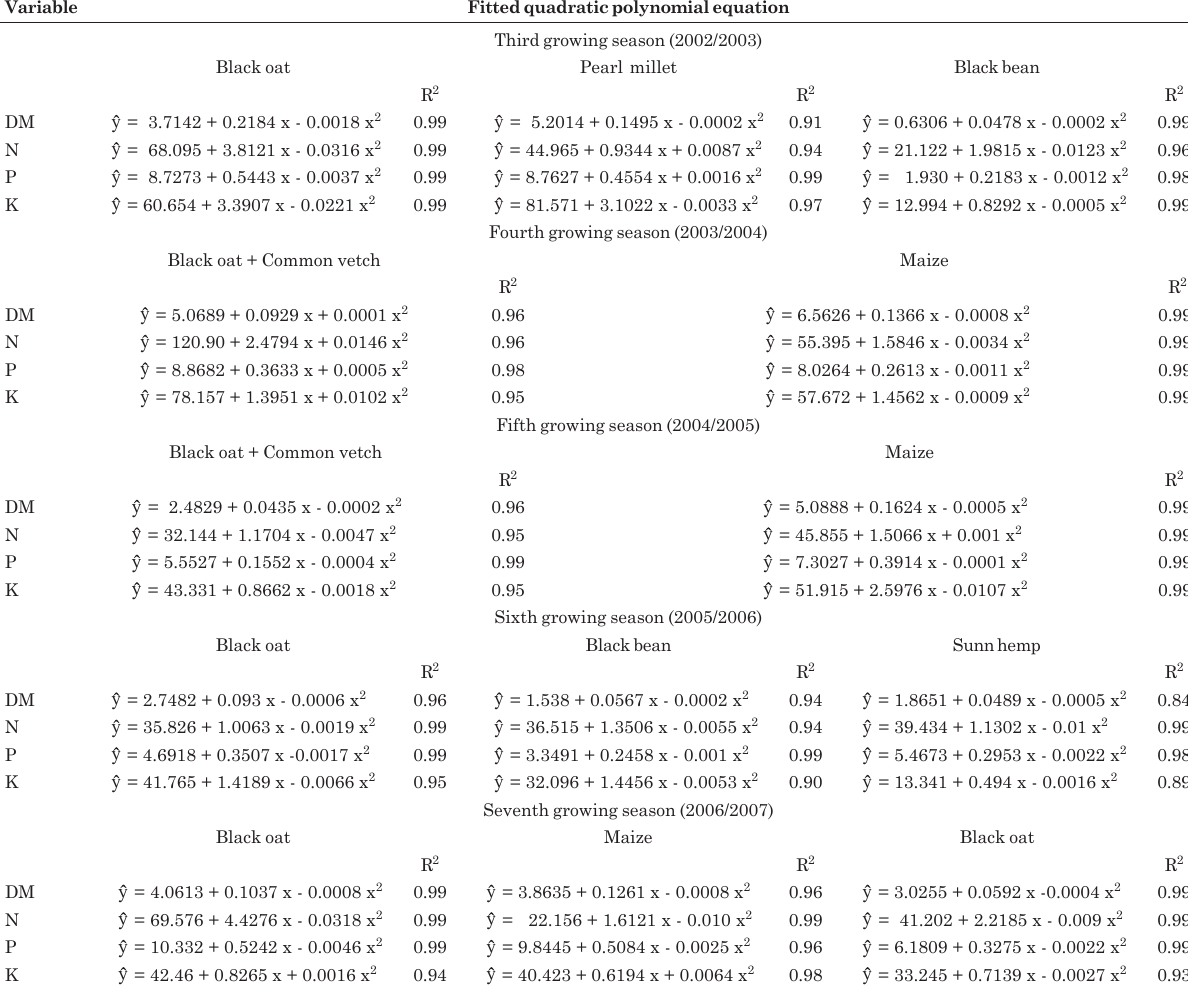
Table 4. Mathematical equations of best fit for dry matter (DM) and nutrient accumulation for different crops and growing